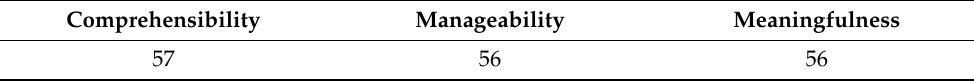
Table 11. The sense of coherence of the ultramarathon